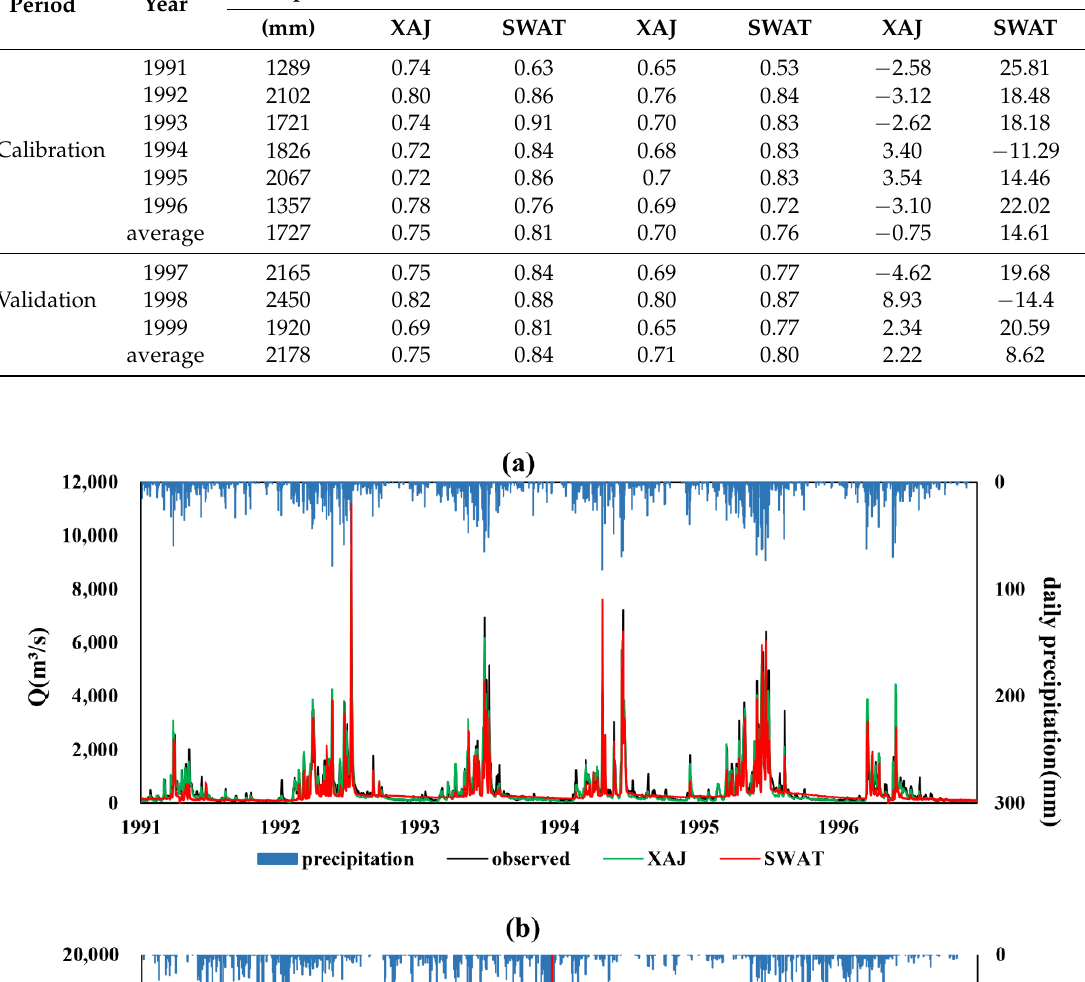
Table 4. Results of calibration and validation for XAJ and SWAT models in daily simulation. Period